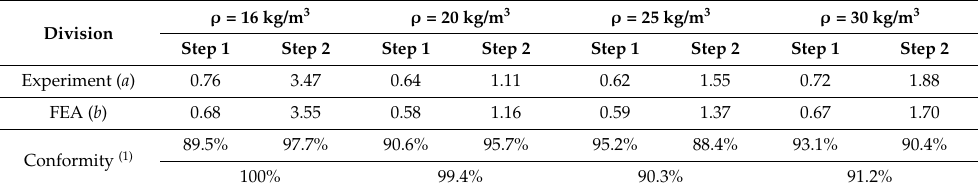
Figure 12. Comparison of experimental and FEA results. Table 6. Concordance of experimental and FEA results.